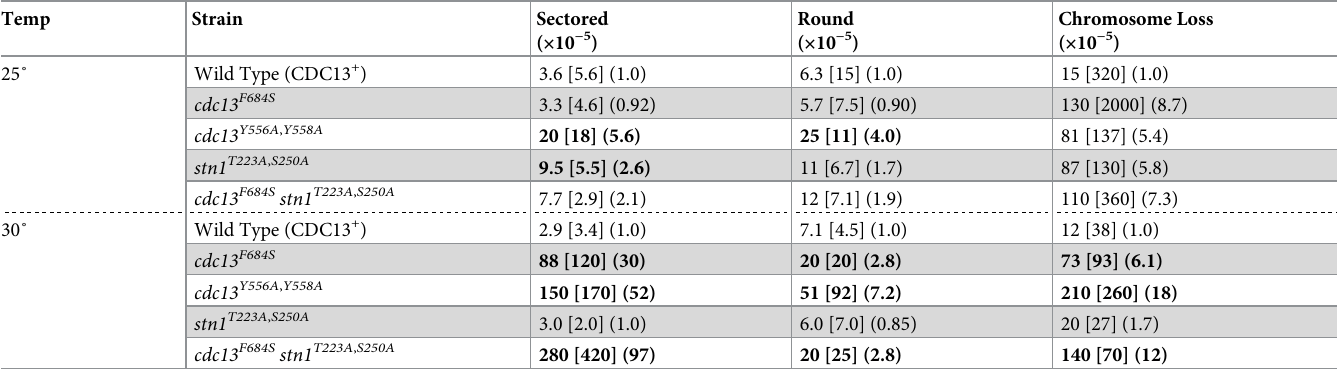
Table 1. Median frequencies of chromosome instability in cdc13 F684S at 25 and 30˚C.